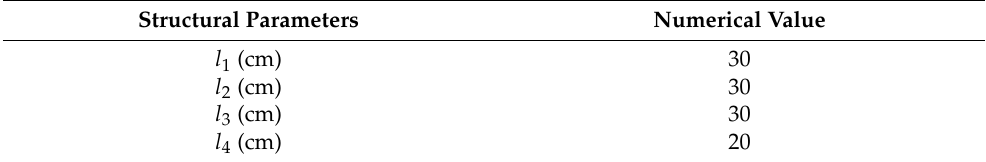
Table 2. Structural parameters of the